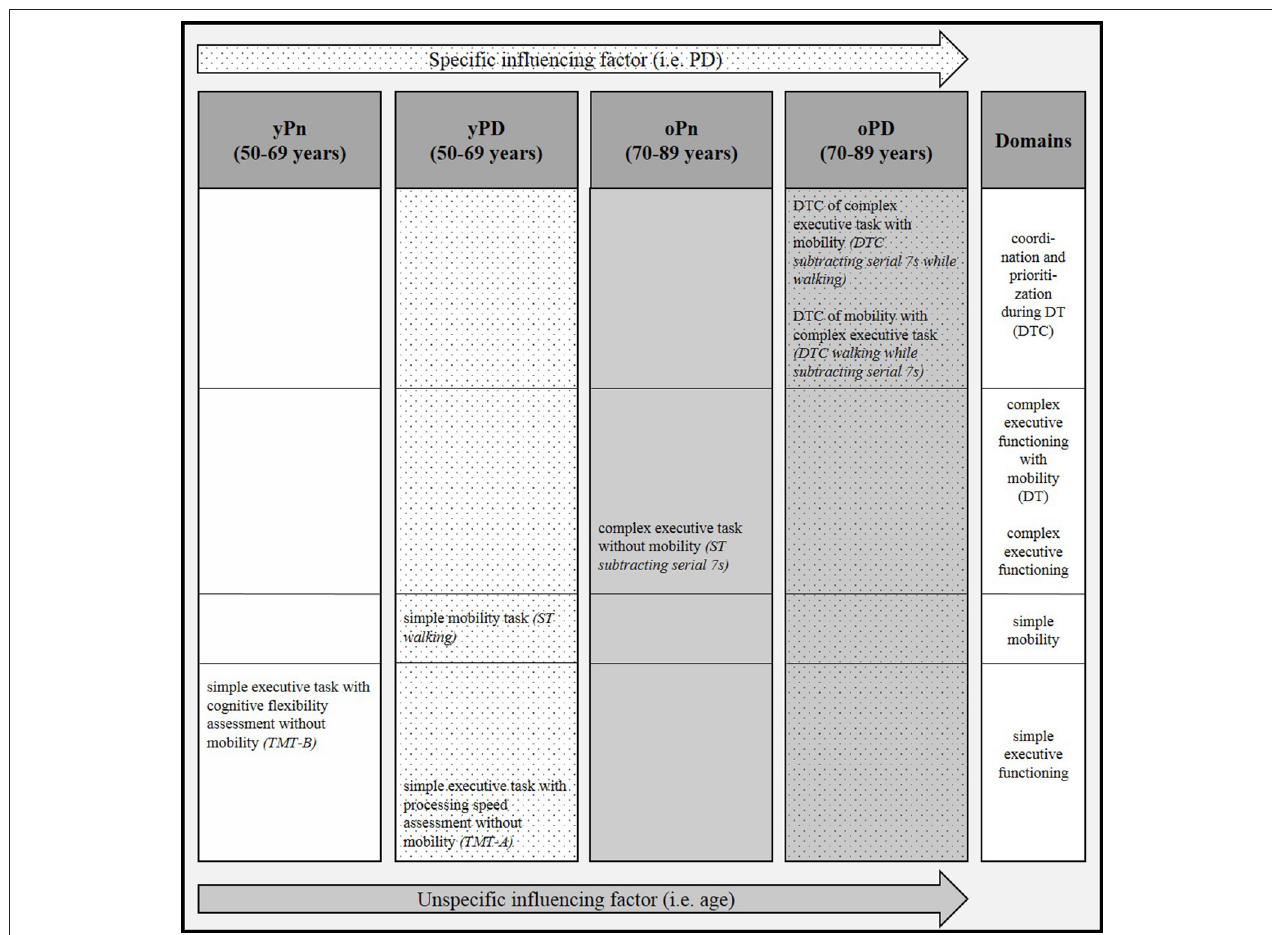
FIGURE 2 | Pattern of significant correlations of severity of white matter changes (WMC) with gait and executive function parameters across four groups with and without advanced age and Parkinson’s disease (PD). DT, dual task; DTC, dual task costs; oPD, old patients with Parkinson’s disease (PD); oPn, old persons without PD; ST, single task; TMT-A, Trail Making Test part A; TMT-B, Trail Making Test part B; yPD, young patients with PD; yPn, young persons without